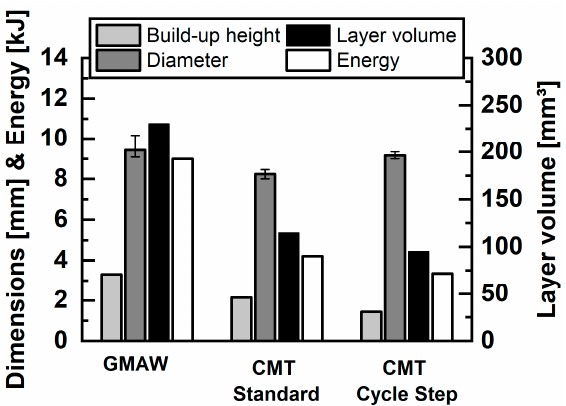
Figure 6. Layer build-up height, diameter, layer volume, and the corresponding energy input of di ff erent welding processes.